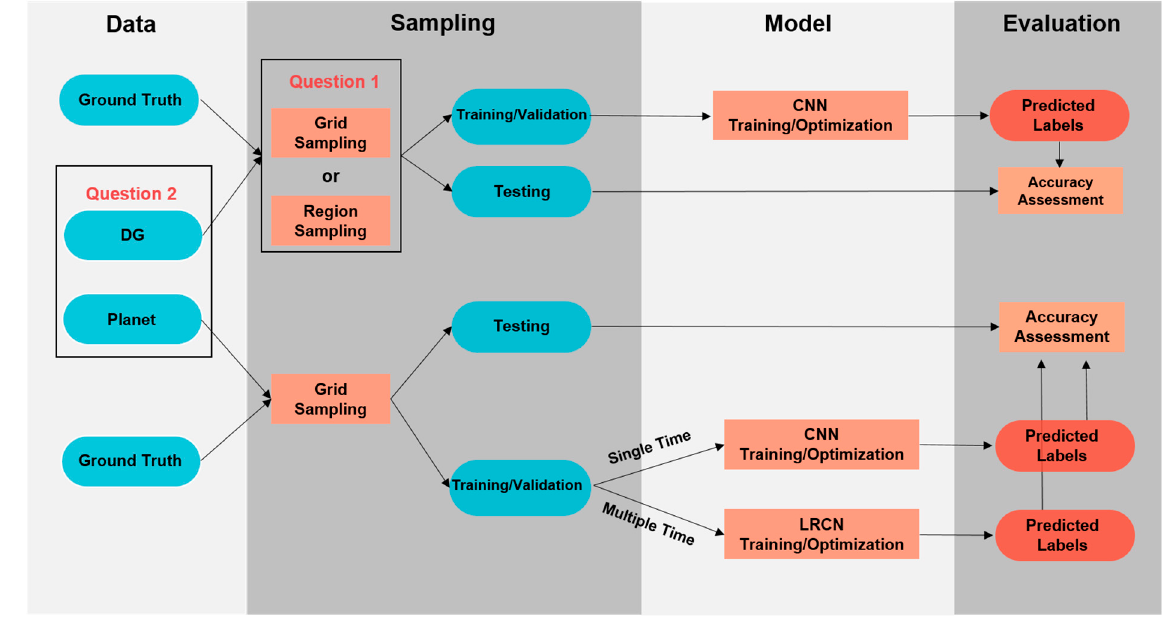
Figure 2. A flowchart overview of methods used in this study.